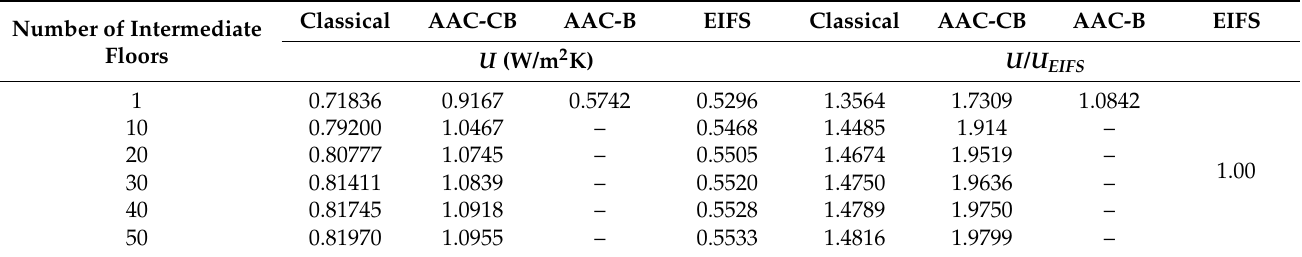
Table 8. Effect of number of intermediate floors on the overall heat transfer coefficient of the high- rise